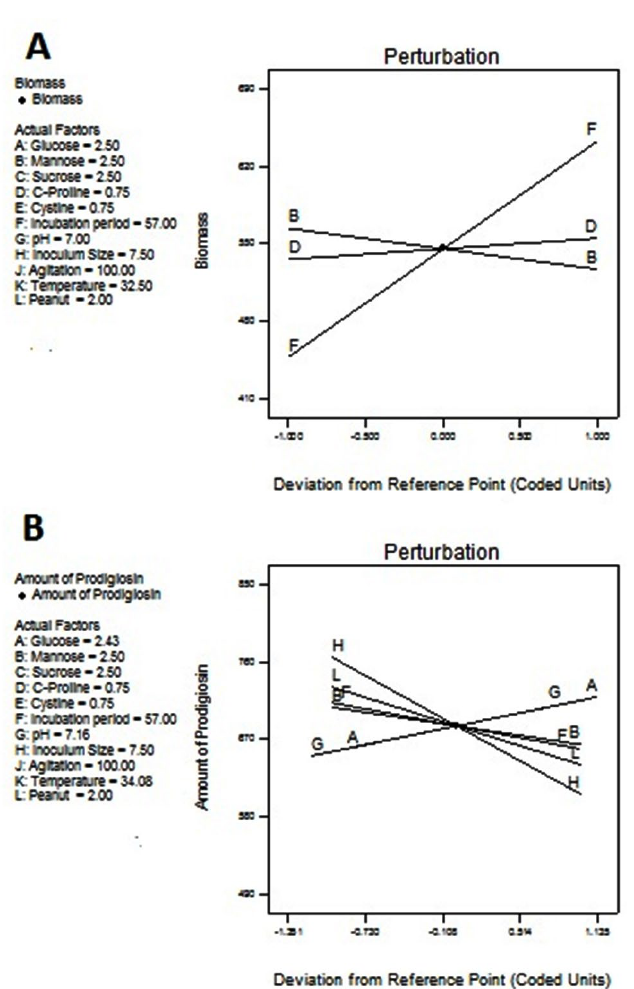
Fig. 5 . Model diagnostic plot by Perturbation graph from Plackett-Burman Design A) Biomass, B) Prodigiosin yield. In this chart A: Glucose, B: Mannose, C: Sucrose, D:L-Proline, E: Cysteine, F: Incubation Period, G: pH, H: Inoculum size, I: Agitation, J: Temperature, K: Percentage